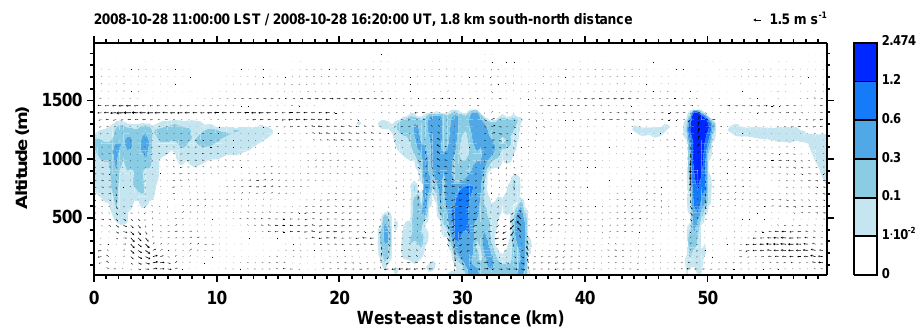
Fig. 6. Liquid water (sum of cloud and rain water), and residual wind velocity in simulation S 0 at 28 October 2008 16:20UT. The maximum updraft velocity is 1.4ms − 1 , the maximum downdraft velocity − 1.2ms − 1